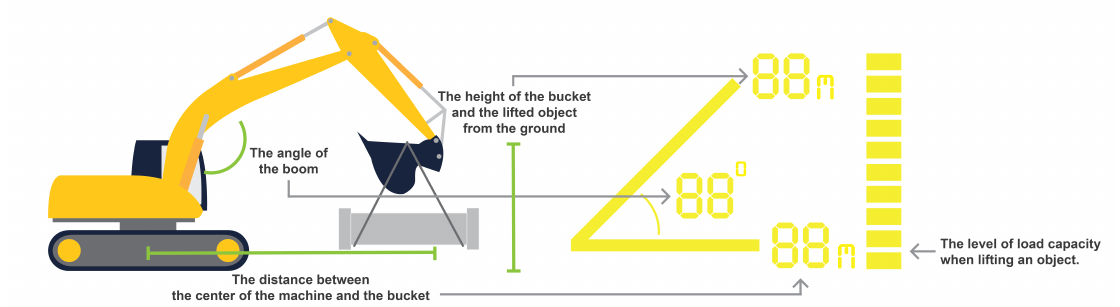
Figure 9. The meaning for each component in the relative load capacity